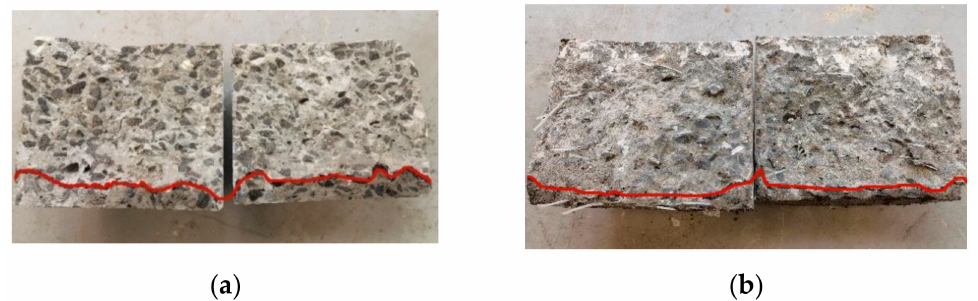
Figure 8. Concrete seepage height chart: ( a ) Reference group; ( b ) hybrid fiber group.